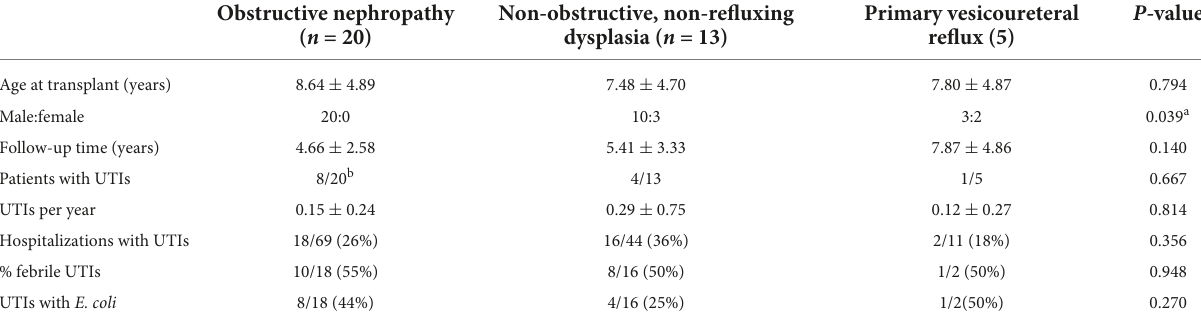
Obstructive nephropathy ( n = 20)